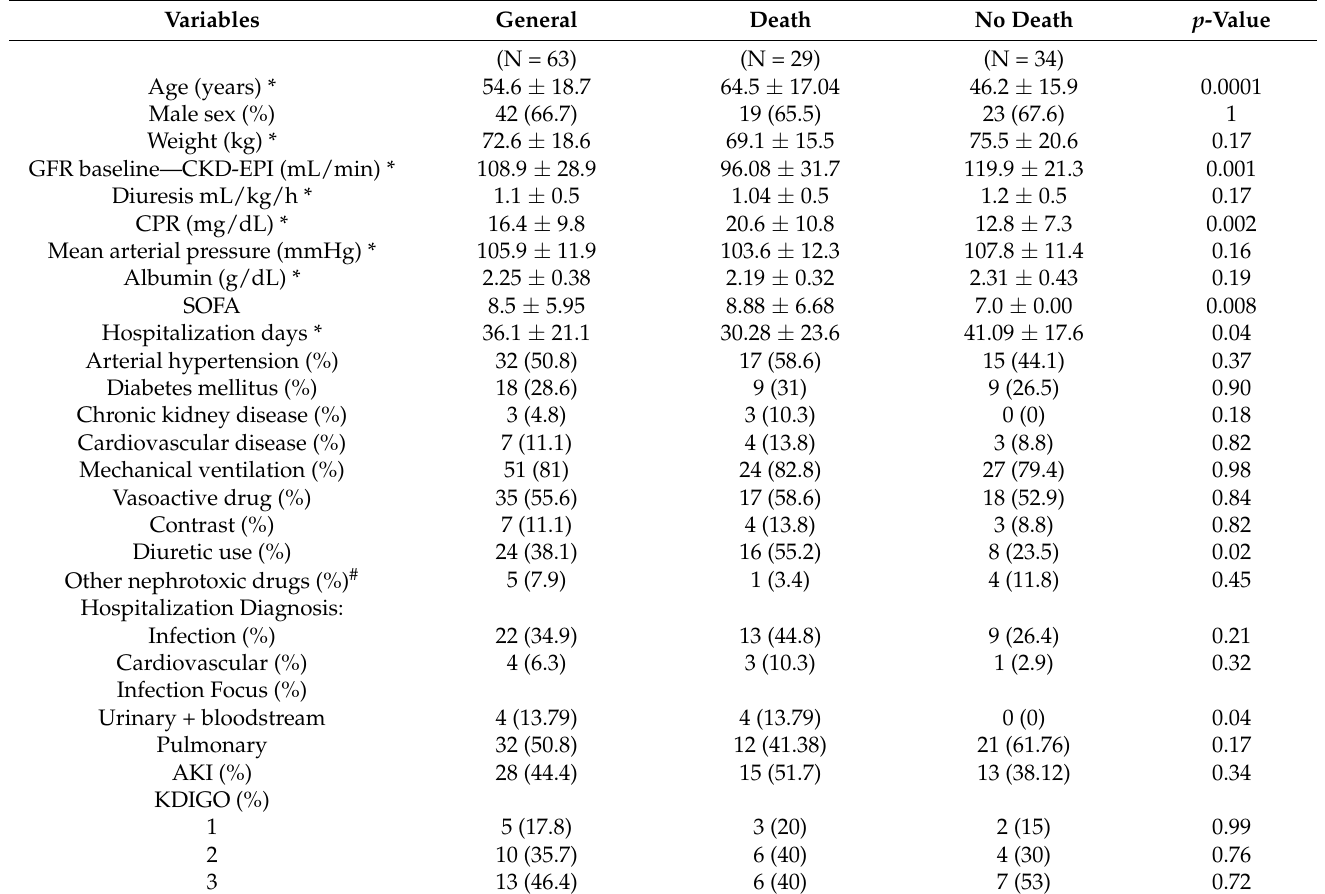
Table 4. Patients’ clinical and laboratory characteristics in the use of vancomycin hospitalized in an intensive care unit, compared to its outcome.